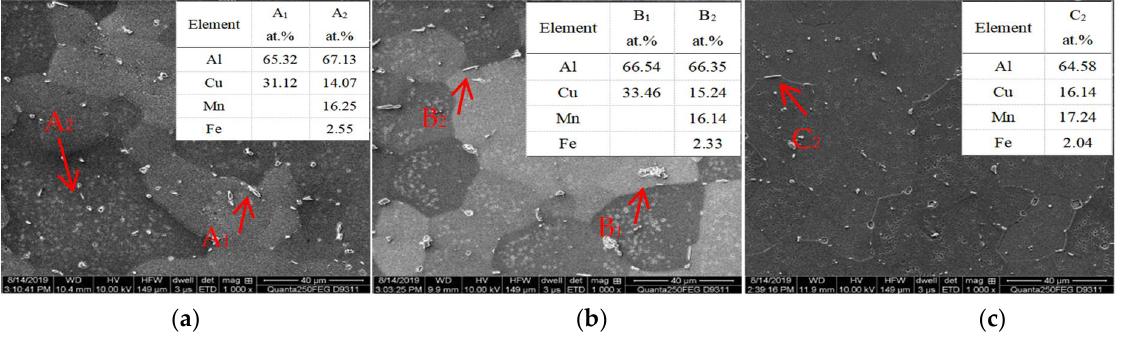
Figure 6. SEM and EDS of ZCL205A alloy deposits manufactured with different deposition processes held at 200 °C for 30 min. ( a ) The SEM image and EDS analysis of a sample prepared using the CMT process, where A 1 is the θ phase, and A 2 is the T phase. ( b ) The SEM image and EDS analysis of a sample prepared using CMT and Pulse process, where B 1 is the θ phase and B 2 is the T phase. ( c ) The SEM image and EDS analysis of a sample prepared using the CMT Pulse and Advanced process, where C 2 is the T phase.